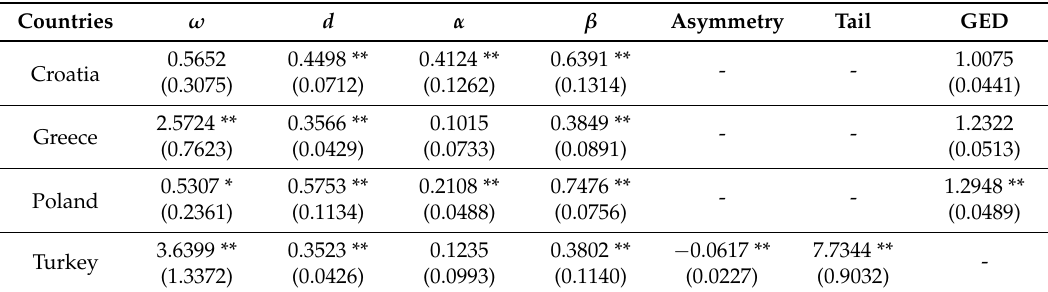
Table 6. FIGARCH (1.1) parameters of the log returns of the original series.